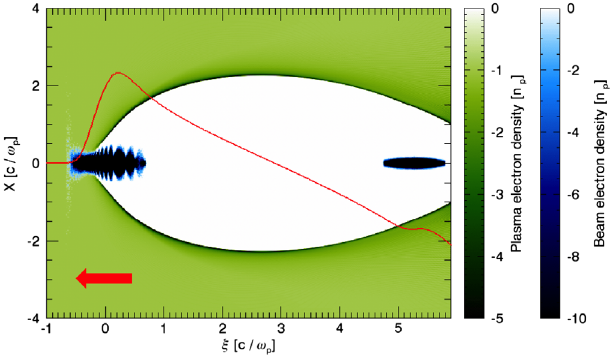
FIG. 1. A snapshot of the drive and witness beam of a sample simulation of a two bunch PWFA. A data is in the x − ξ plane at y ¼ 0 . Both beams (blue) are propagating to the left. The green area shows the unperturbed plasma electron density, the white area is the uniform plasma ions (ion channel/bubble). The red curve is the lineout of the accelerating field E z on the axis (in arbitrary